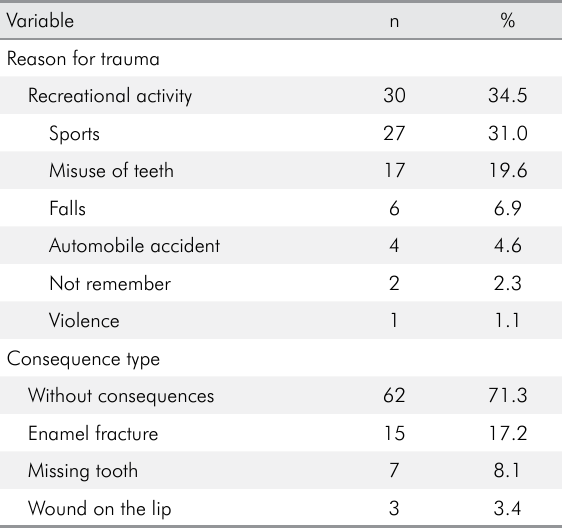
Table 3. Crosstabulation of variables: reason for trauma and consequences of trauma.